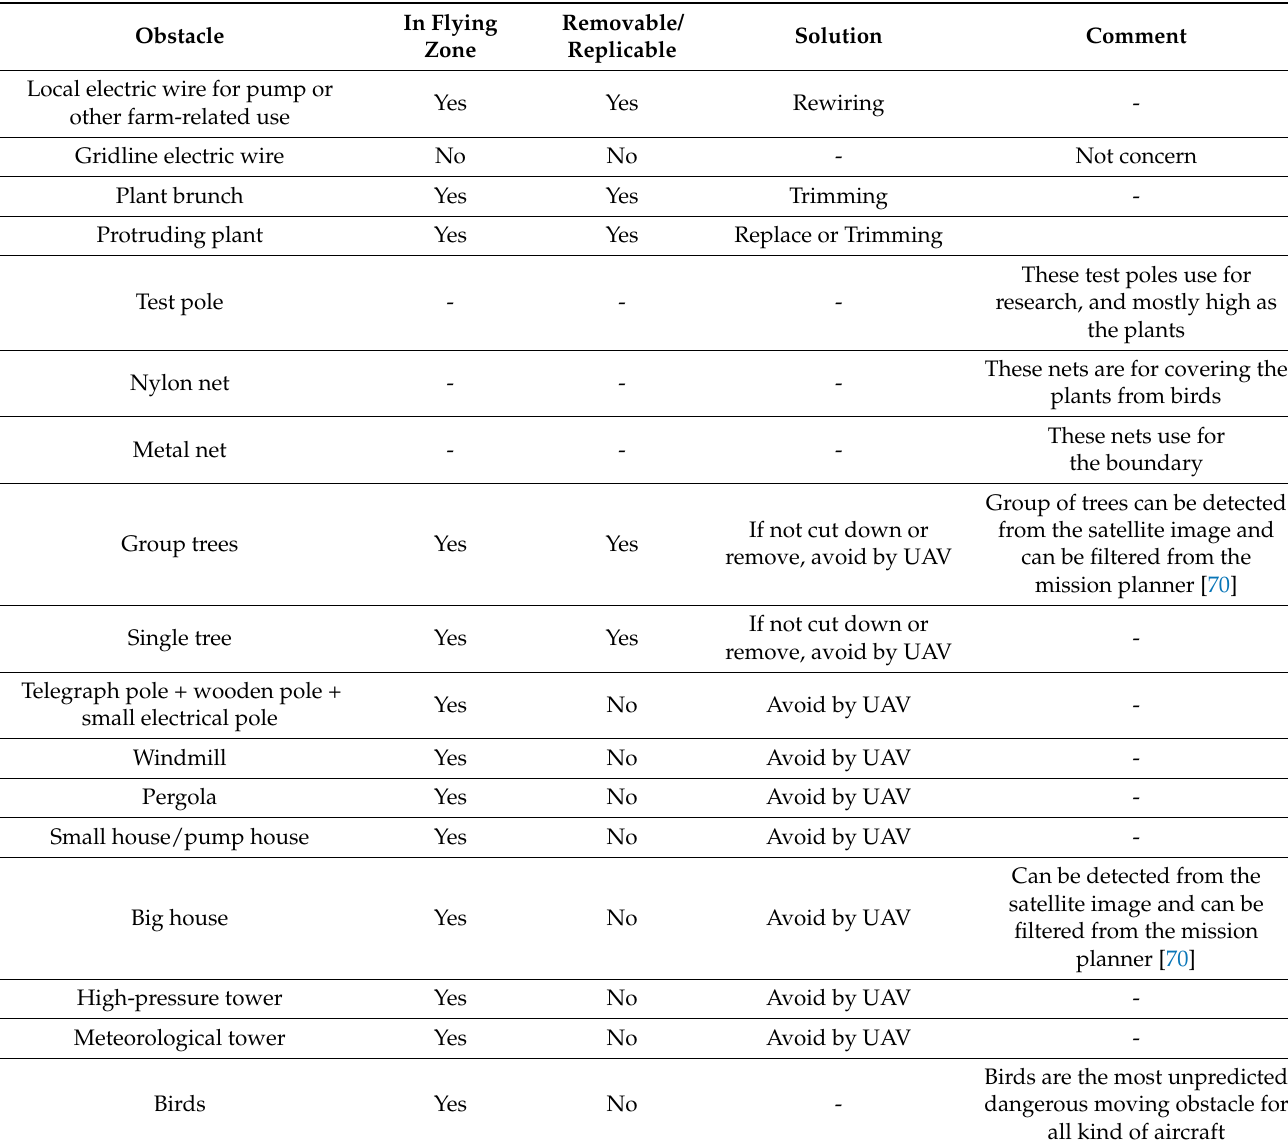
Table 1. Possible obstacles on